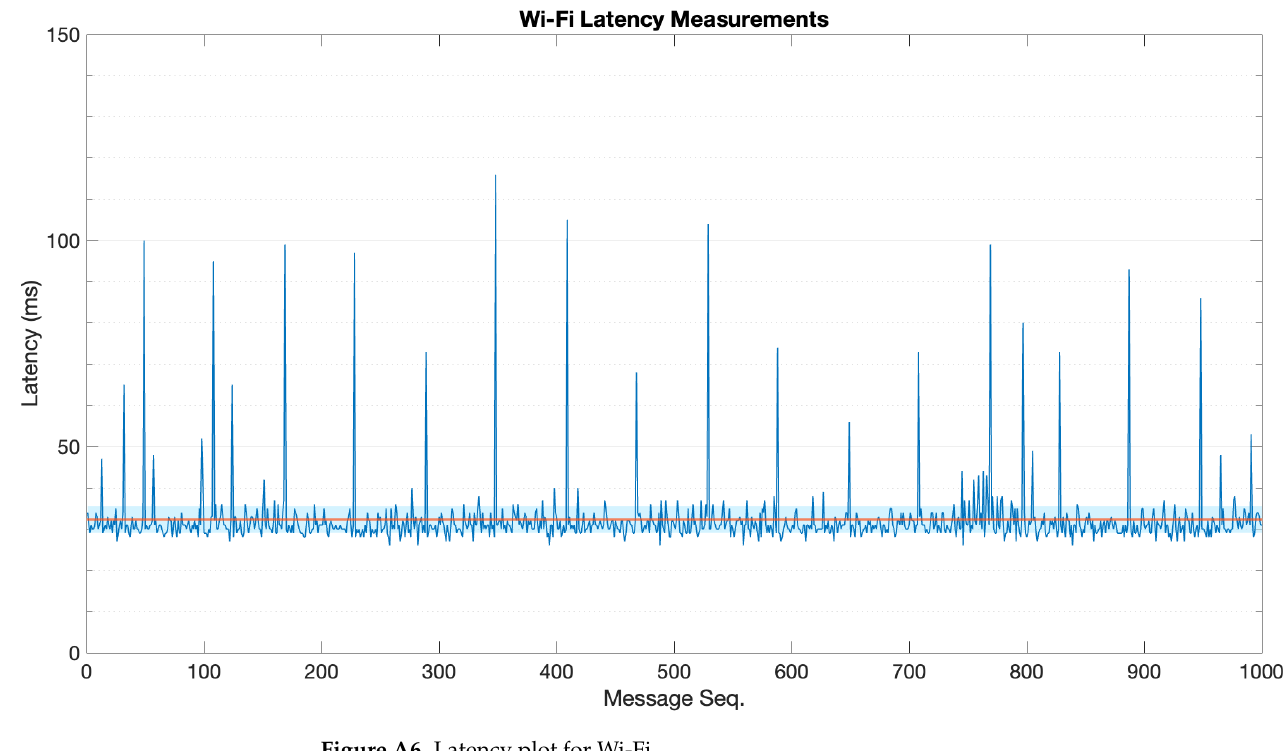
Figure A6. Latency plot for Wi-Fi.